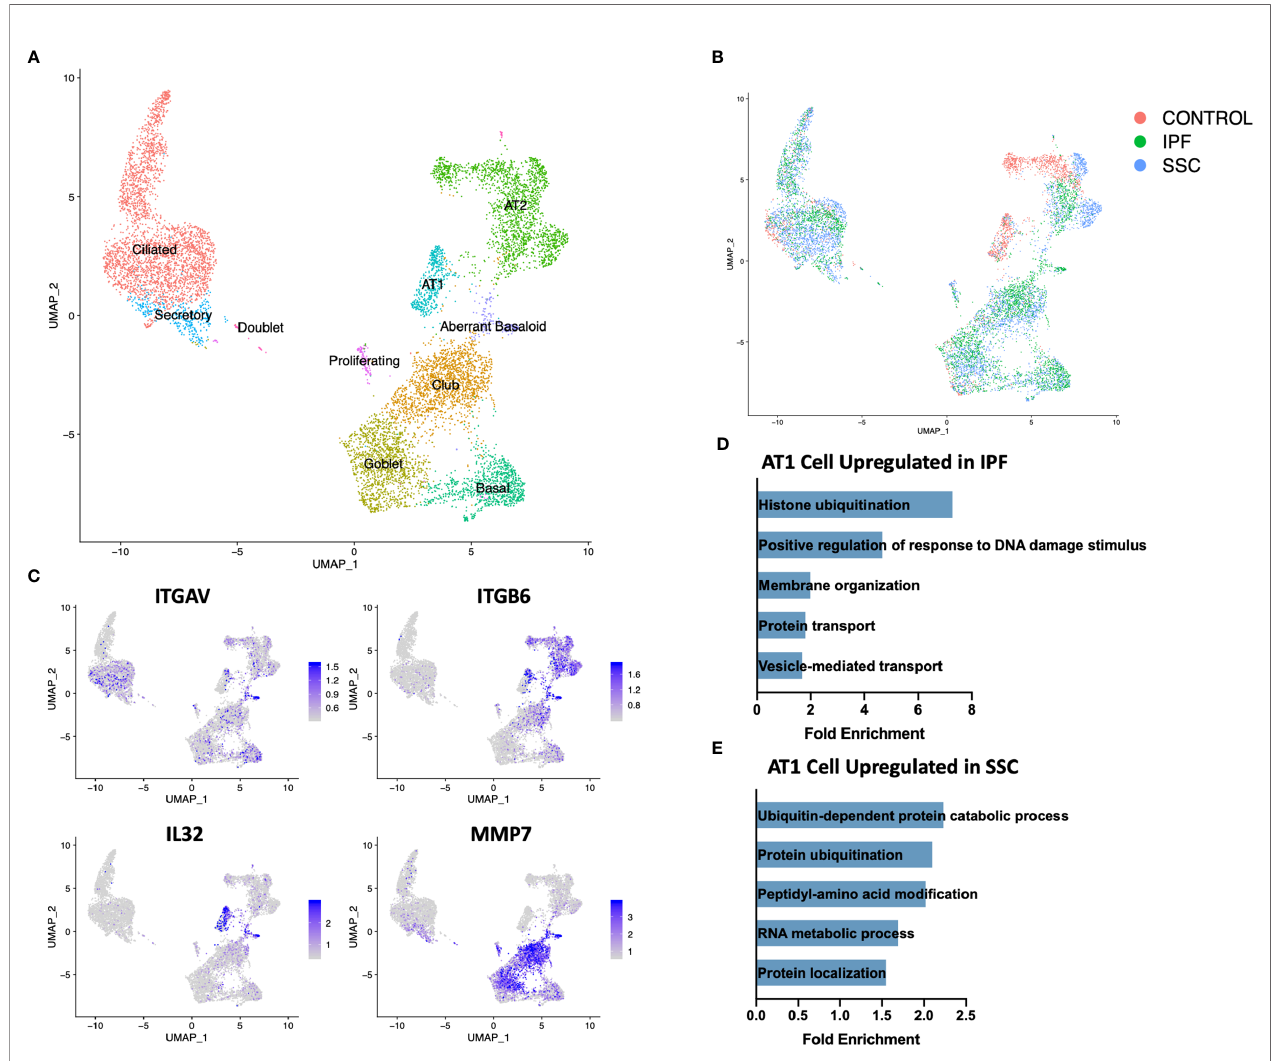
FIGURE 5 | ScRNA-seq analysis of IPF, SSc-ILD, and control epithelial cell populations. (A) UMAP plot of epithelial cell populations, identi fi ed by cell type (B) UMAP plot of epithelial cell populations, identi fi ed by disease status. (C) Expression of ITGAV, ITGB6, IL32 , and MMP7 , highlighting the aberrant basaloid population. (D) Pathways upregulated in IPF AT1 cell gene signature compared to SSc-ILD AT1 cell gene signature. (E) Pathways upregulated in SSc-ILD AT1 cell gene signature compared to IPF AT1 cell gene signature. scRNA-seq, single-cell RNA-sequencing; IPF, idiopathic pulmonary fi brosis; SSc-ILD, systemic sclerosis- associated interstitial lung disease; UMAP, uniform manifold approximation and projection; AT1, alveolar type